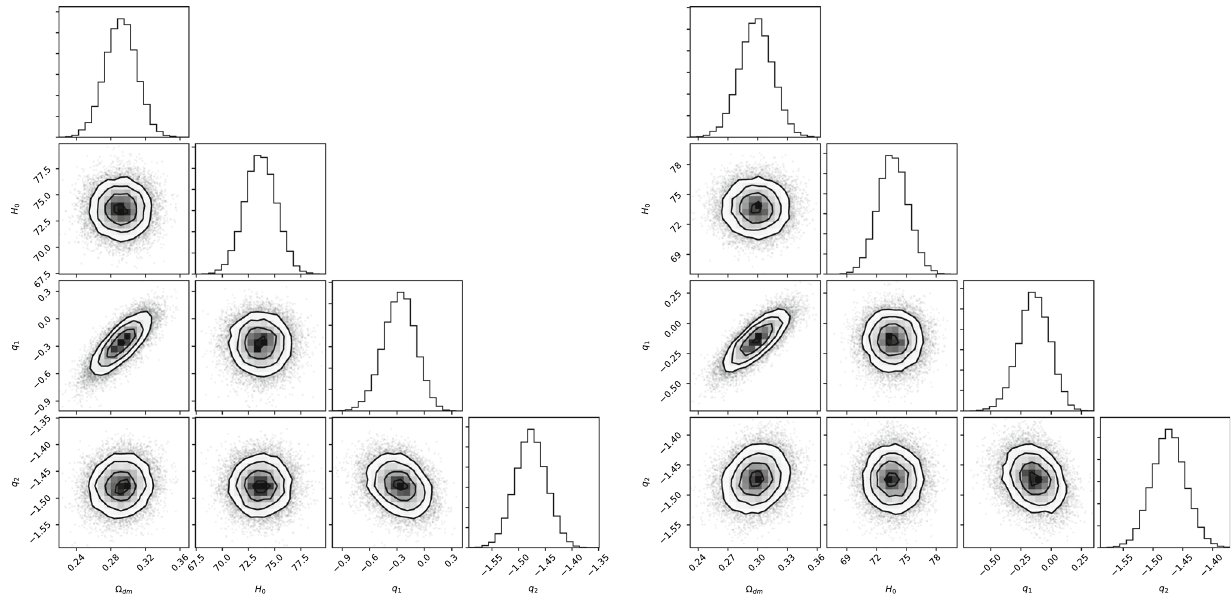
Fig. 3 ThecontourmapofthemodelgivenbyEq.(16),for z ∈ [ 0 , 2 . 5 ] , is given by the left hand side plot. The one on right hand side corre- sponds to the contour map of the same model, for z ∈ [ 0 , 5 ] . The best fit values of the model parameters are, respectively, (cid:8) dm = 0 . 322 ± 0 . 01, H 0 = 73 . 64 ± 1 . 5 km/s/Mpc, q 1 = − 0 . 27 + 0 . 181 − for z ∈ [ 0 , 2 . 5 ] , while for z ∈ [ 0 , 5 ] they are found to be (cid:8) dm =